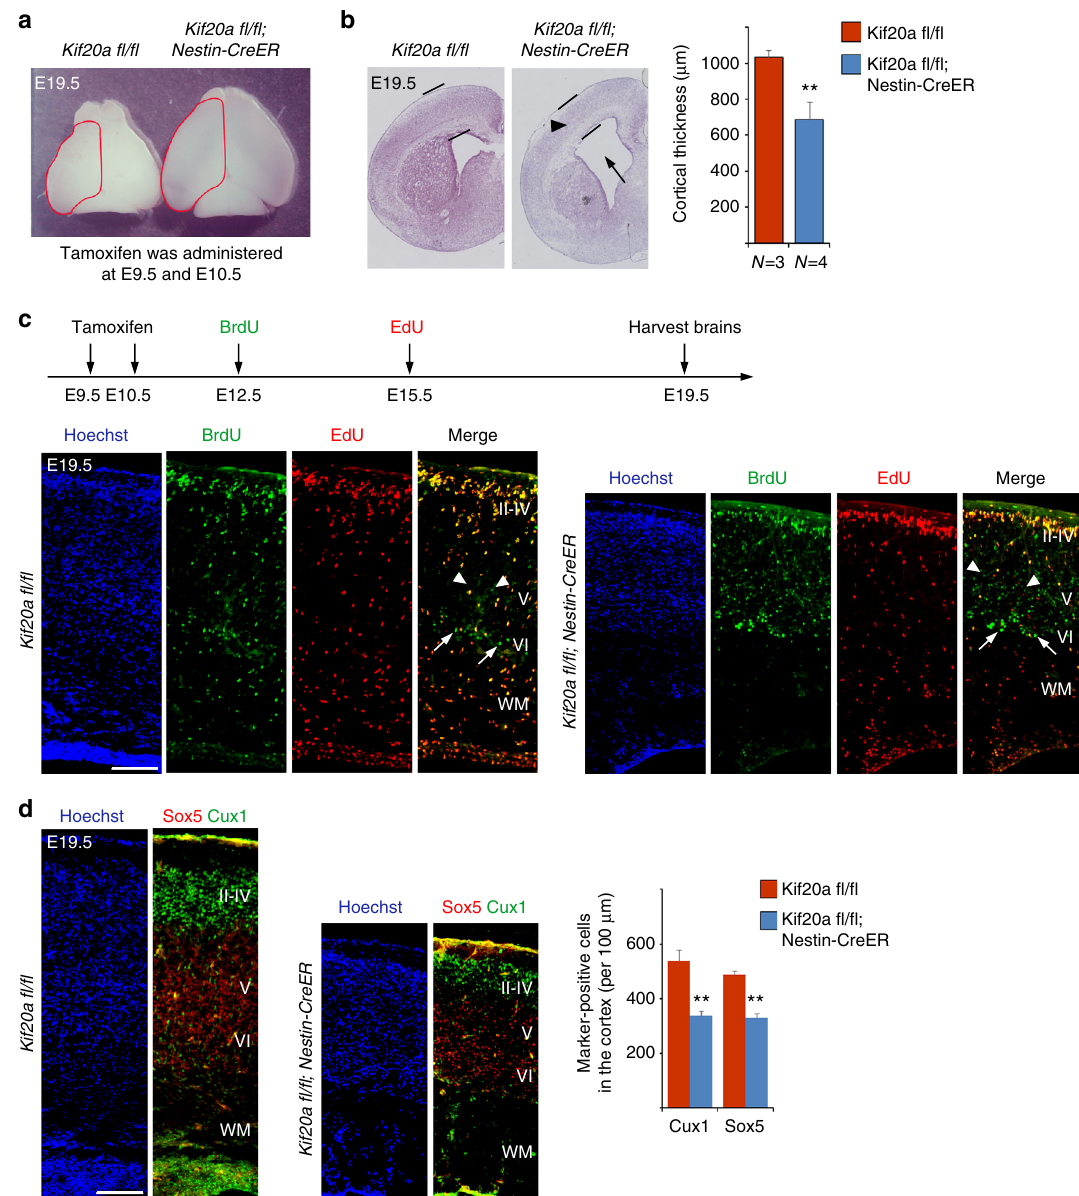
Fig. 8 Inducible knockout of Kif20a in NPCs causes ventriculomegaly and defect in cortical neuronal production. a Tamoxifen was administered to pregnant mice carrying Nestin-CreERT2 ; KIF20A fl / fl and control KIF20A fl / fl littermates at E9.5 and E10.5. Pups were delivered by C-section (E19.5). Inducible knockout of Kif20a yielded brains with elongated cortical hemispheres. b Nissl staining of brain sections revealed thinner cortices (black arrowhead) and dilated ventricles (black arrow) of the Kif20a mutant brains. ** P < 0.01. Error bars represent SD. c BrdU and EdU were sequentially administered at E12.5 and E15.5, respectively. In both Nestin-CreERT2 ; KIF20A fl / fl mice and control KIF20A fl / fl mice, BrdU + EdU - cells (early-born neurons) and BrdU + EdU + cells (late-born neurons) were located in the respective deep and upper layers, suggesting Kif20a knockout did not affect cortical lamination. More BrdU + EdU − cells could be seen in the deep layers of Kif20a mutant brains, re fl ecting early cell cycle exit due to LOF of KIF20A. Arrows and arrowheads indicated bright and dim BrdU positive cells, respectively. d SOX5 + and CUX1 + cortical neurons in both Nestin-CreERT2 ; KIF20A fl / fl mice and control KIF20A fl / fl mice were seen correctly located in deep layers and upper layers, respectively. Neuronal productions, however, were compromised in the cortices of the mutant mice. Scale bar represents 100 μ m. ** P < 0.01. Error bars represent